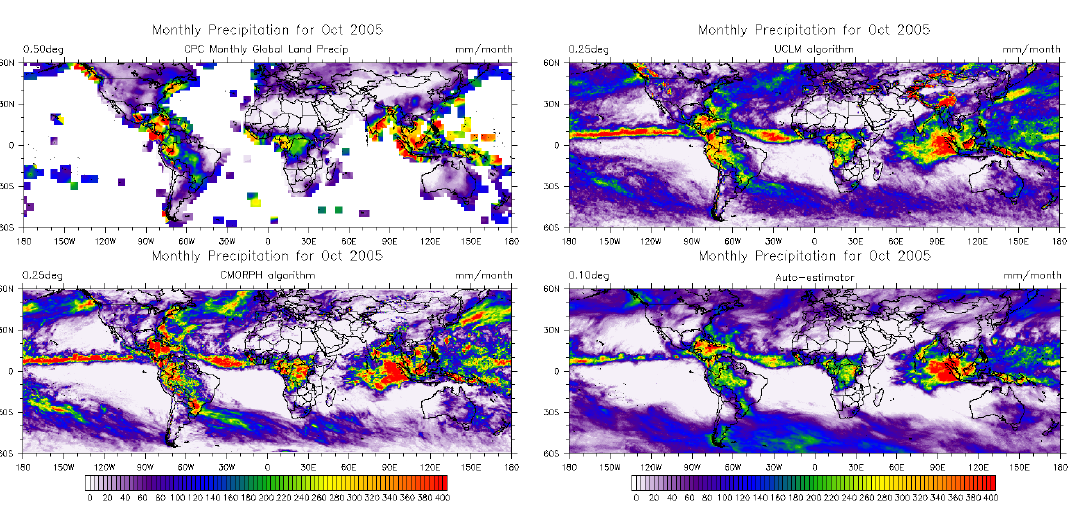
Figure 2. October 2005 precipitation estimates using a morphed microwave algorithm (top right, UCLM algorithm) and infrared-calibrated algorithms (bottom, CMORPH and AUTO-ESTIMATOR algorithms) compared to Climate Prediction Center (CPC) global land precipitation field (top left).